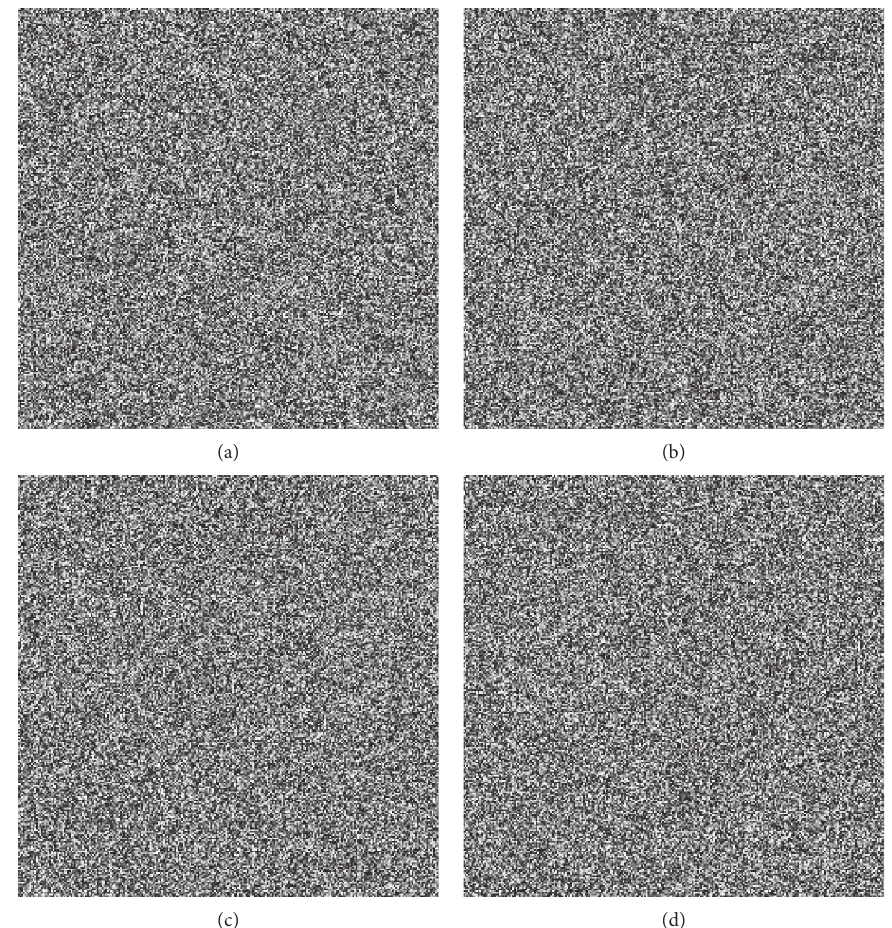
Figure 11: Key sensitivity analysis results. (a) Encryption result of key decryption result of using key